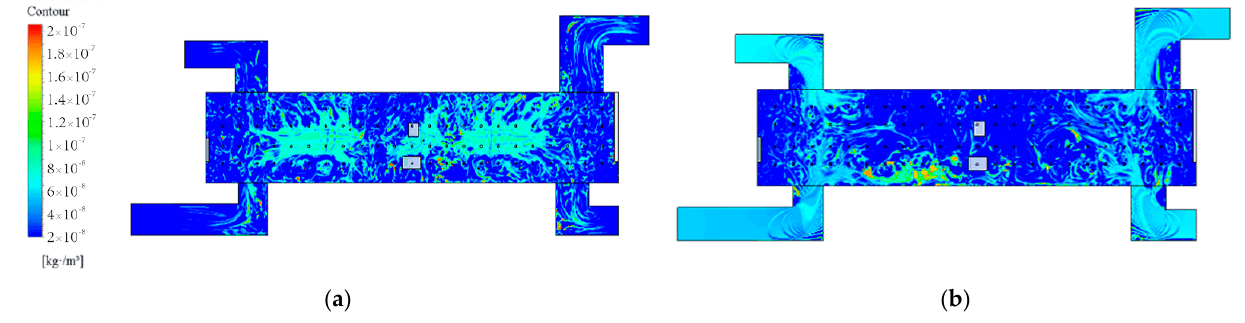
Figure 12. Simulation results of the airflow field at the station concourse floor under different air- flow organization: ( a ) PSDs closed; ( b ) PSDs opened. Figure 13. Simulation results of particle mass concentration contour at the station concourse floor under different airflow organization: ( a ) PSDs closed; ( b ) PSDs opened.